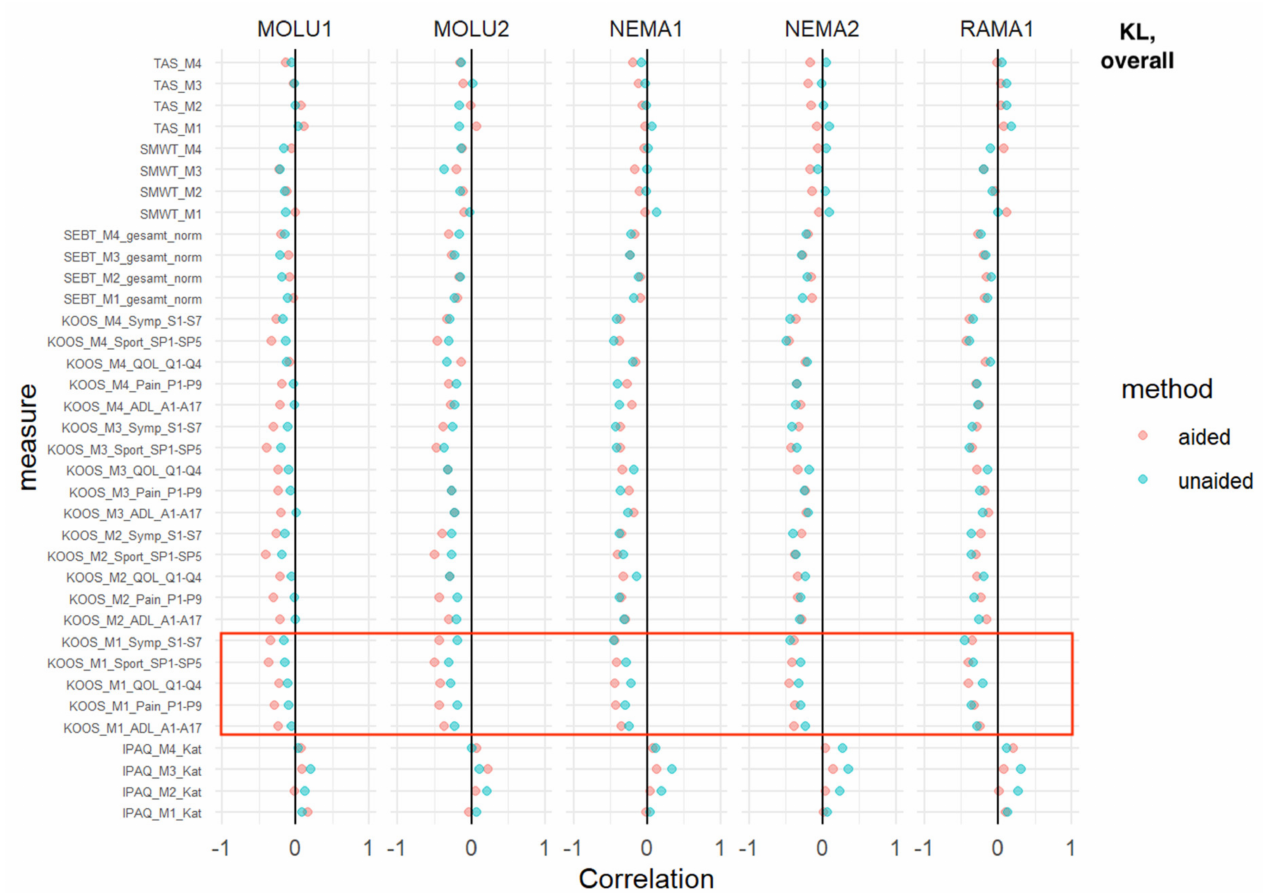
Figure 3. Overall KL —correlation analysis for AI-aided (red dots) versus AI-unaided (green dots) readings with clinical scores. Red square marks all baseline KOOS scores